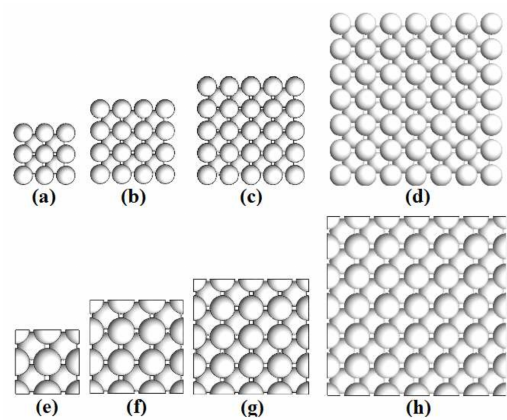
Figure 6. Body-centered cubic (BCC) samples; named as ( a ) 1; ( b ) 2; ( c ) 3; ( d ) 4; ( e ) 1cut; ( f ) 2cut; ( g ) 3cut; ( h ) 4cut.